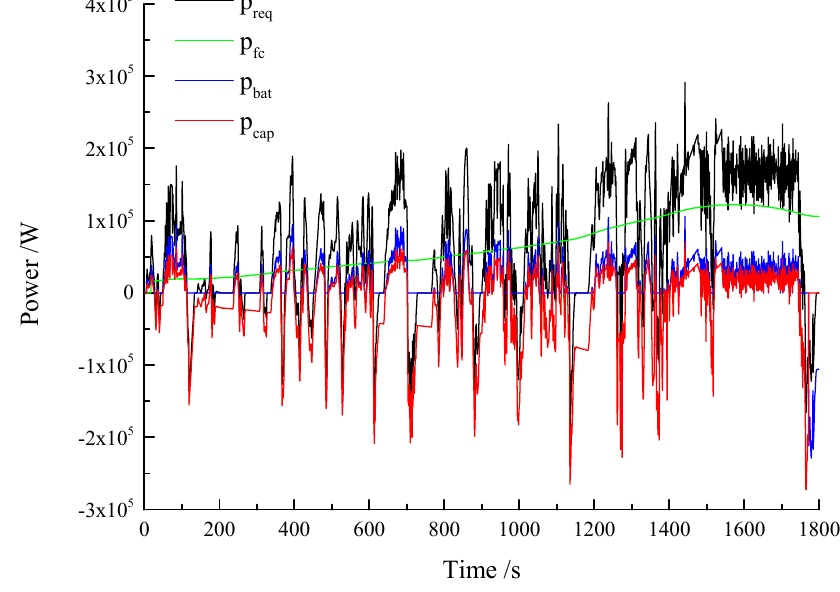
Figure 10. Relationships between power output and power demand by the three energy